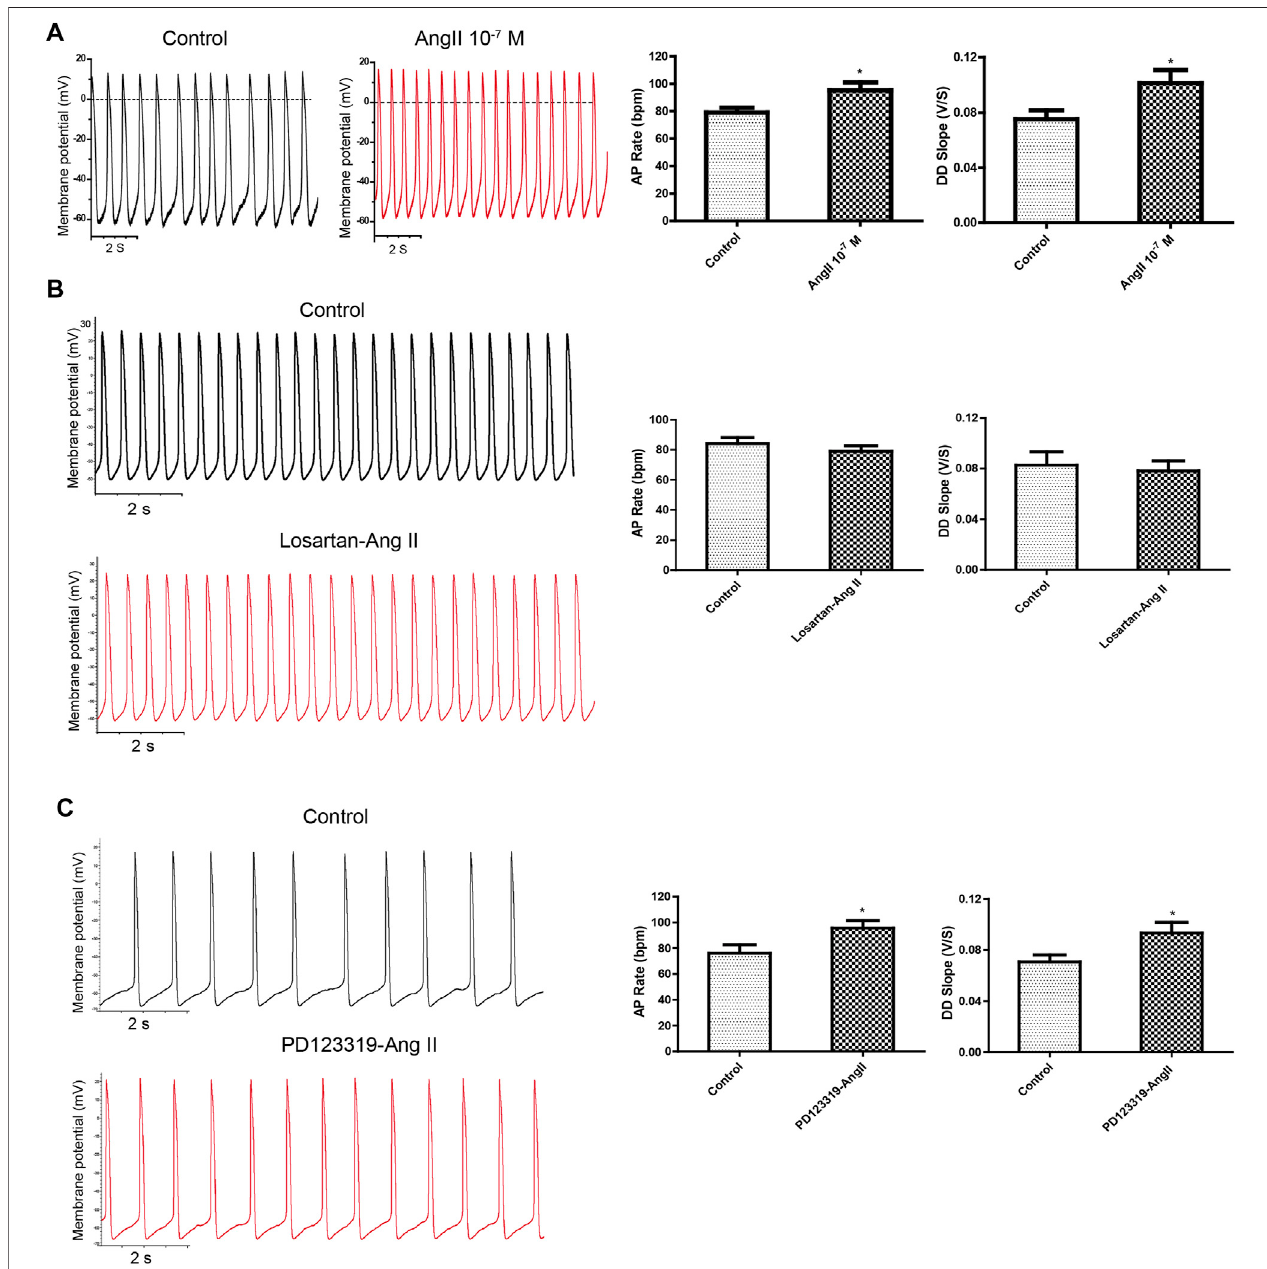
FIGURE2 | Application ofexogenousAng IIincreasedAPs transiently, and theeffectcould be attenuated bythe AT 1 Rblockerbut not theAT 2 R blocker. (A) Ang II increased the APs of mESC-CMs in a transient manner. Raw traces of spontaneous APs at the basal level and upon treatment with 10 – 7 M Ang II in mESC-CMs (left panel) . Summarized data on the AP rate and the DD slope of APs (right panel) . (B) AT 1 R blocker attenuated Ang II – induced changes in APs. Raw traces of spontaneous APs at the basal level and upon treatment with 50 μ M losartan, followed by the subsequent application of 10 – 7 M Ang II in mESC-CMs (left panel) . Summarized data on the AP rate and the DD slope of APs at the basal level or upon treatment with 50 μ M losartan, followed by 10 – 7 M Ang II (right panel) . Losartan attenuated Ang II – induced changes in the parameters of APs. (C) AT 2 R blocker did not affect Ang II – induced changes in APs. Raw traces of spontaneous APs at the basallevel and upontreatmentwith10 μ MPD123319,followedbythe subsequent applicationof10 – 7 MAng IIinmESC-CMs (leftpanel) . Summarized dataon theAP rate and the DD slope of APs at the basal level or upon treatment with 10 μ M PD123319, followed by 10 – 7 M Ang II (right panel) . PD123319 did not affect Ang II – induced changes in the parameters of APs. Values are mean ± SEM of 4 – 6 independent experiments. * p < 0.05 vs. control group.